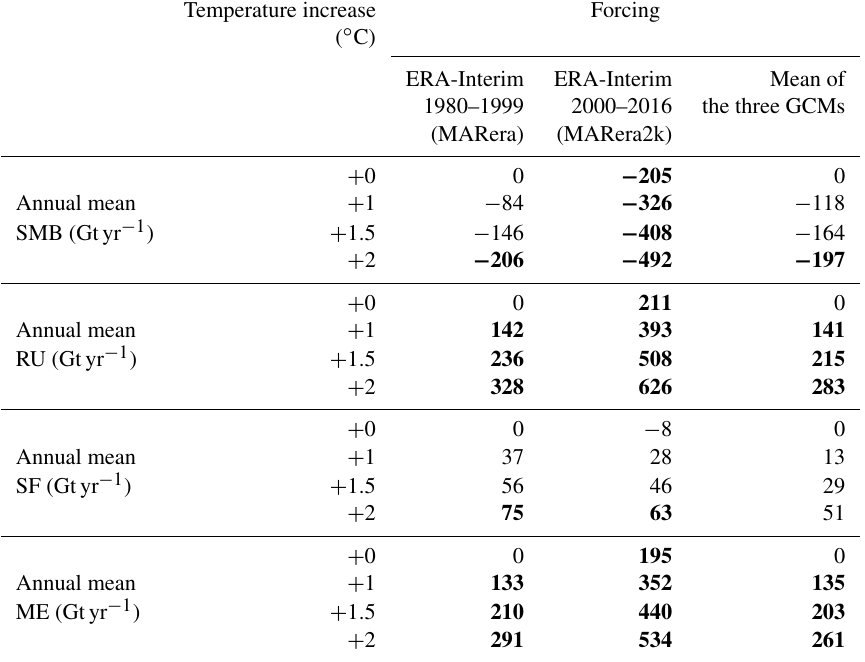
Table 2. Mean GrIS-integrated anomalies of annual SMB (Gty − 1 ), RU (RU), snowfall (SF), and melt (ME) compared to 1980–1999. Anomalies from GCM-forced simulations are given as averaged. Anomalies greater than the 1980–1999 standard deviation (i.e. greater than the inter-annual variability) of the simulation of MAR forced by unaltered ERA-Interim are shown in